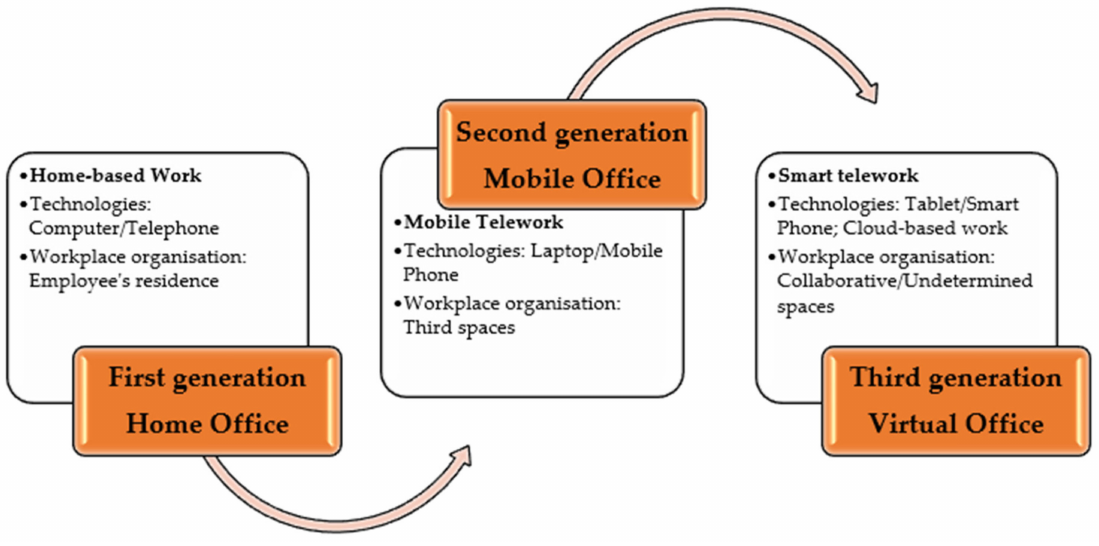
Figure 1. The conceptual framework for telework